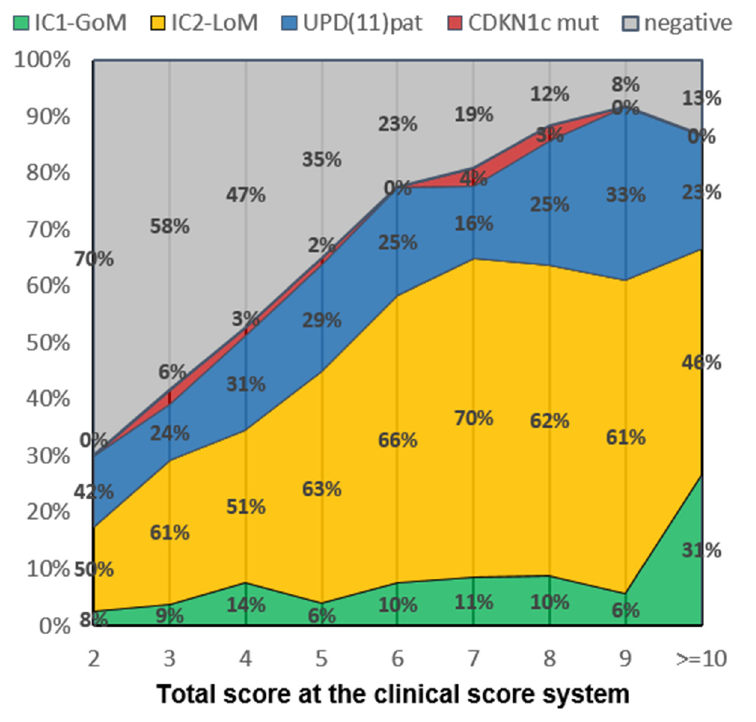
Figure 3. Molecular breakdown for each of the points of the consensus scoring system [10]. Percentages of the negative cases (in gray) refer to the total, while percentages in the four subgroups refer to the total of positive cases including gain of methylation at imprinting center 1 (IC1 ‐ GoM, in green), loss of methylation at imprinting center 2 (IC2 ‐ LoMm in orange), paternal uniparental disomy of the 11p15.5 chromosomal region (UPD(11)pat, in blue), and pathogenic variants in CDKN1C (CDKN1c mut, in red). Tumors : Table 3 details the 48 patients who developed a total of 50 tumors (2 patients Table 3. Patients with cancer and tumor type divided by molecular group and consensus score. had 2 tumors). A consistent difference in tumor risk was found in the four molecular defects, with the risk ranging from the highest (19.2%) in IC1 ‐ GoM to the lowest in IC2 ‐ ConsensusScore a LoM (1.6%) ( p < 0.001). Tumor types were 26 WT (4 bilateral), 7 HB, 5 adrenal carcinomas (AK), 4 neuroblastomas (NB), 2 pancreatoblastomas (PB), 1 Sertoli cell tumor (SCT), 1 hepatocarcinoma (HC), 1 acute lymphoblastic leukemia (LLA), 1 Hodgkin lymphoma